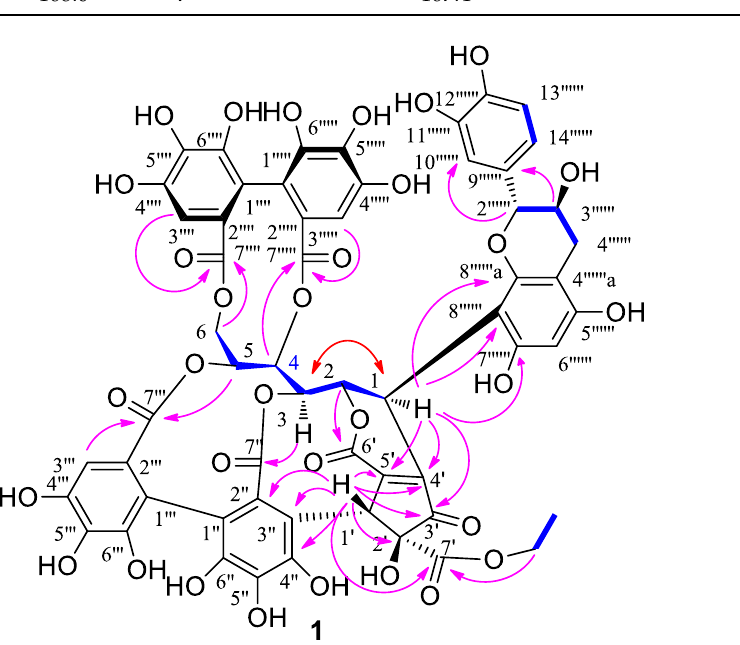
Figure 2. Key HMBC (arrows), 1 H- 1 H COSY (bonds), and NOE (double arrows) correlations of 1 . Table 2. 1 H (500 MHz) and 13 C NMR (125 MHz) spectroscopic data for 11 in DMSO- d 6 .